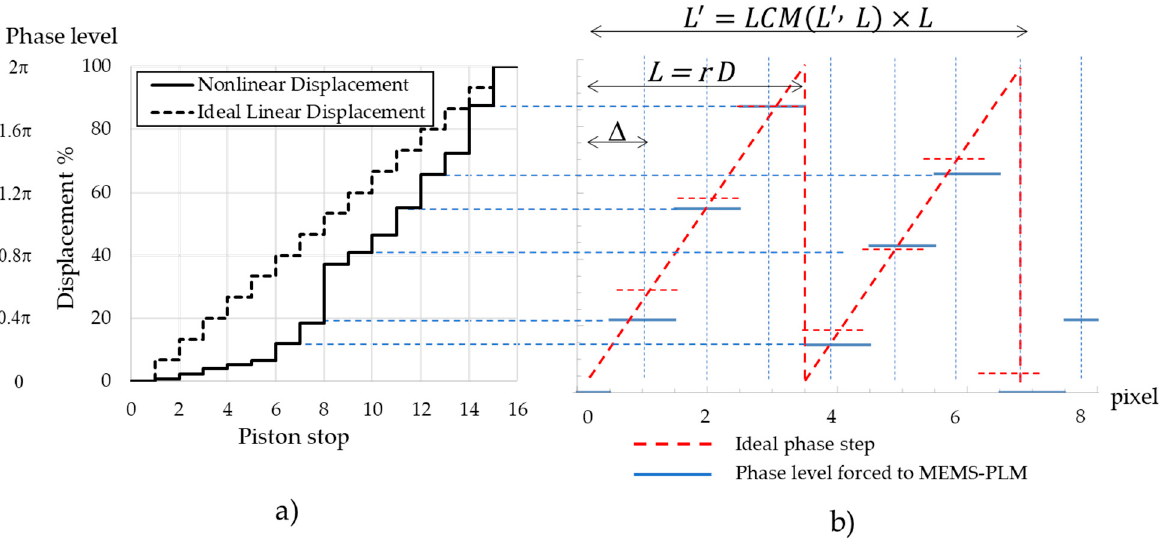
Figure 2. ( a ) Phase profile of 16 equally spaced (dotted line) and realizable phase of TI-PLM (solid line), ( b ) mapping of realizable phase of MEMS PLM to staircase-approximated sawtooth phase